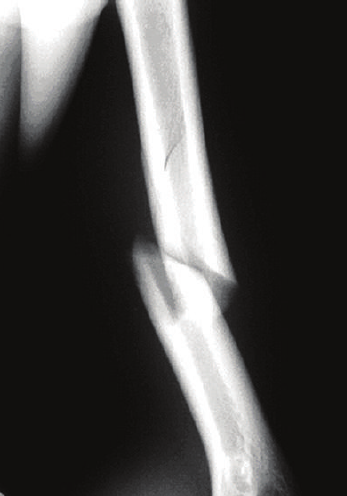
Figure 1: Original internal rotation view showing a spiral fracture at the junction of the middle and distal thirds of the left